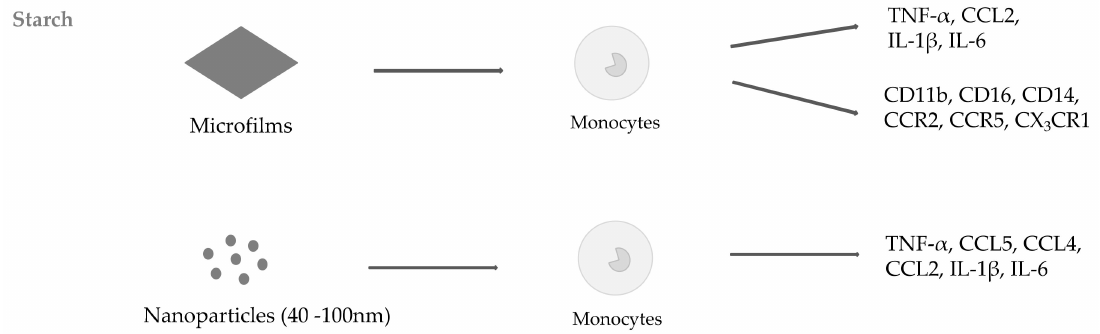
Figure 2. Representation of cytokine release and immune receptor expression induced by starch microfilms and polysaccharide nanoparticles